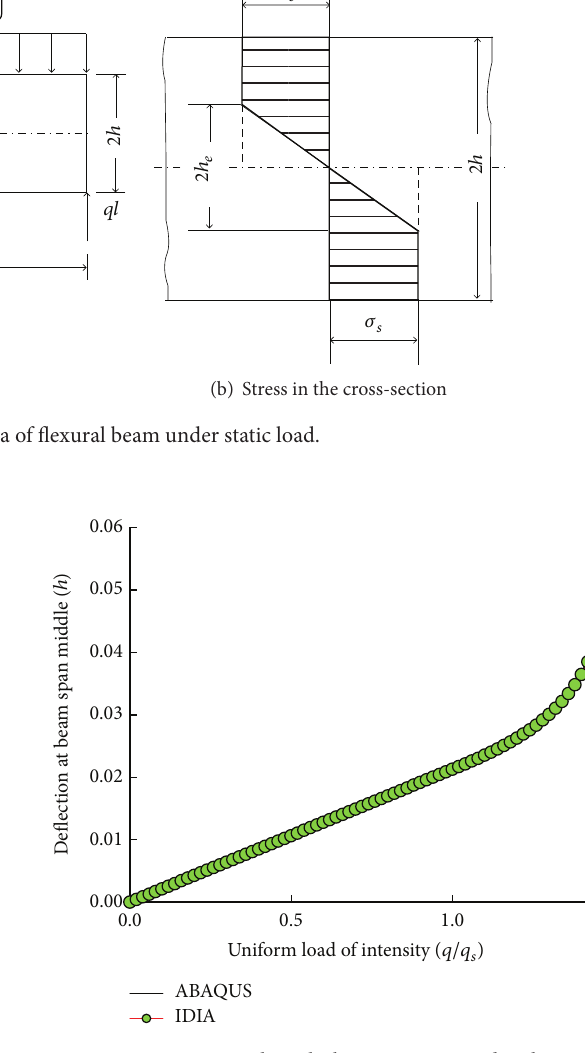
Figure 4: Computational results by IDIA compared with